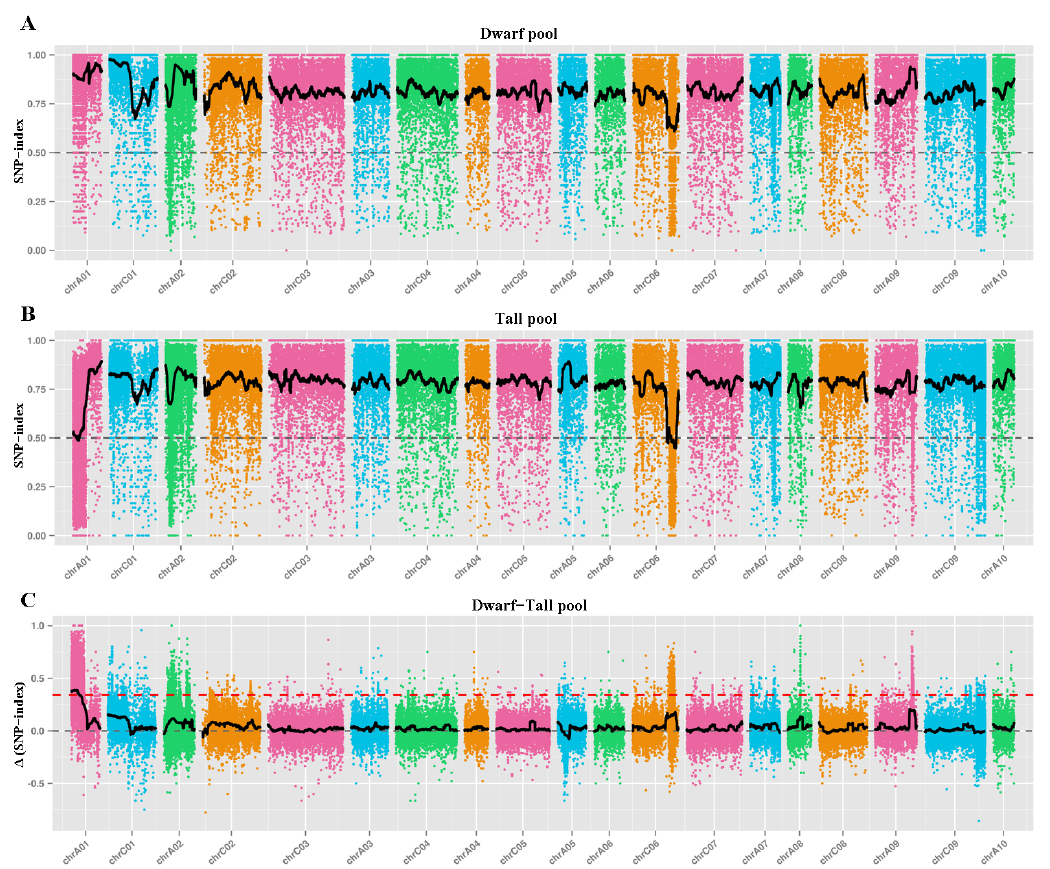
Figure 3. Mapping the genomic region of Brassica napus by BSA-seq. ( A ) The SNP index distribution of the dwarf pool from the BC8F1 population. ( B ) The SNP index distribution of the tall pool from the BC8F1 population. ( C ) Δ (SNP-index) plot of the dwarf and tall pools. The threshold line is the red dashed line.